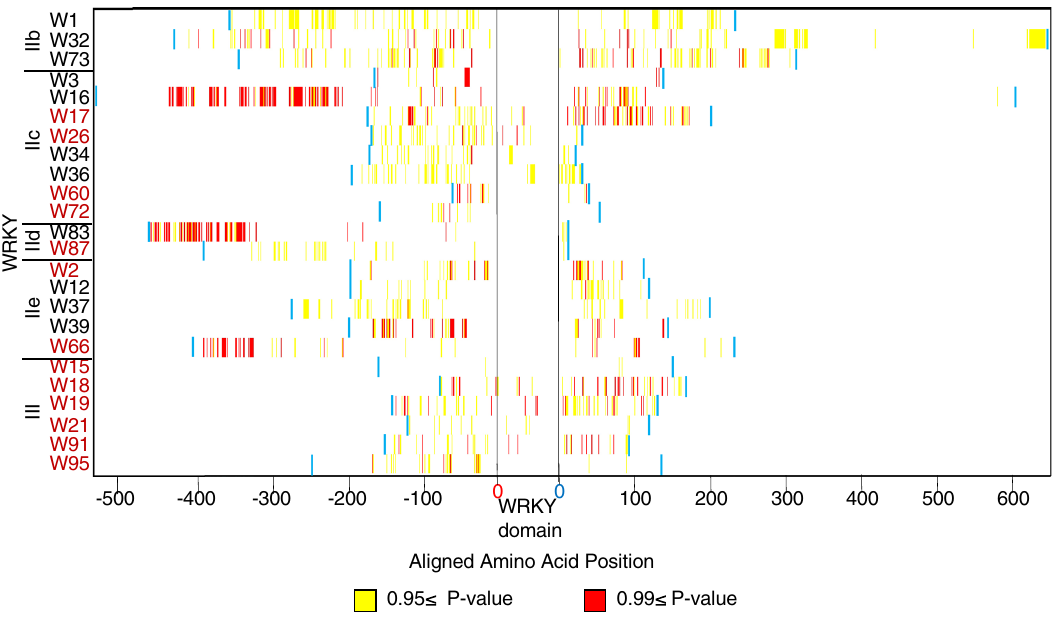
Figure 7. Analysis of sites under highly significant positive selection suggests high conservation of the WRKY domain throughout the Oryza genus with mutations predominantly occurring outside the domain. Representative single copy ortholog WRKYs are arranged according to group shown on the left. WRKYs in red font are determined to be highly conserved based on the site model PAML tests in Table 2 (Supplementary Table S7). Double domain containing Group I WRKYs were not included in the diagram. Amino acids are aligned relative to the location of the WRKY domain with red and blue 0 indicating first and last amino acid of the domain. Bayes-Empirical-Bayes estimates of dN/dS at each amino acid were analyzed using PAML; yellow bars represent sites with p-values ≥ 0.95 and red bars p-values ≥ 0.99. Non-significant data (p-value < 0.95) is not indicated. Blue bars mark the start and end of each WRKY